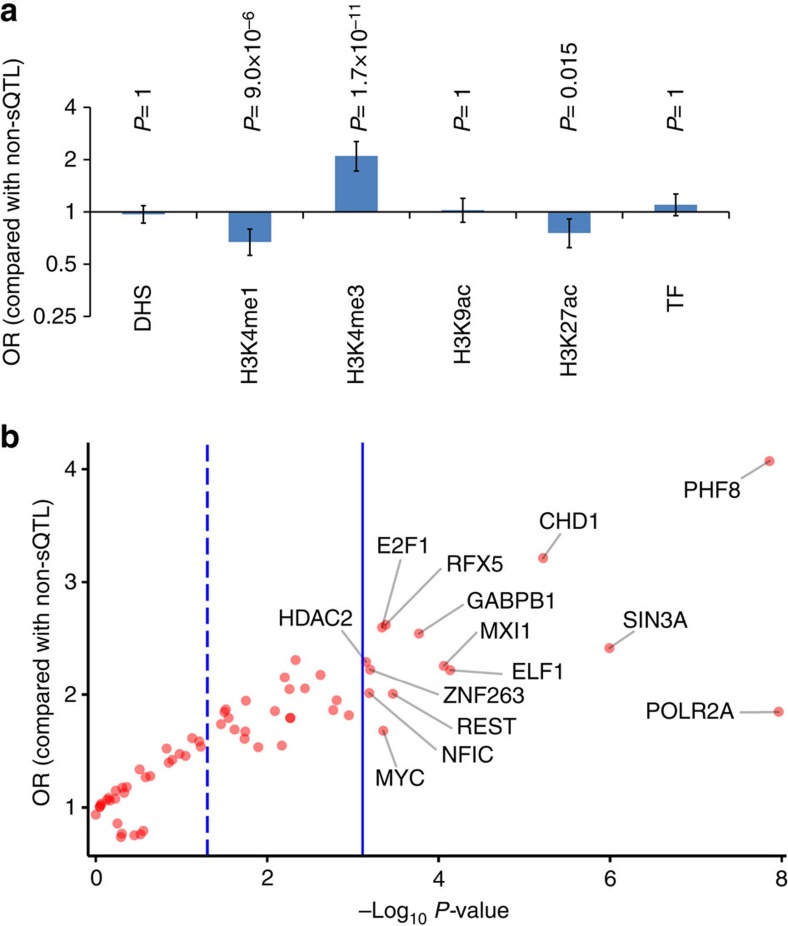
Enrichment analyses of sQTL SNPs among variants within genetic regulatory elements.(a) Enrichment analysis of sQTL SNPs among variants within six types of regulatory elements (DNase I hypersensitive sites (DHS), H3K4 monomethylation marks (H3K4me1), H3K4 trimethylation marks (H3K4me3), H3K9 acetylation marks (H3K9ac), H3K27 acetylation marks (H3K27ac) and TF binding sites). P-values were calculated by two-tailed Fisher's exact test with Bonferroni correction according to the number of regulatory elements analysed (six elements). Bars indicate 95% confidence intervals. (b) Plots of −log10
P-values (x axis) and OR (y axis) obtained from enrichment analysis of sQTL SNPs among variants within binding sites for each TF. The dashed blue line indicates P=0.05 and the solid blue line indicates P=0.05/65=7.7 × 10−4 (Bonferroni-corrected P-value threshold, binding sites for a total of 65 TF were tested).